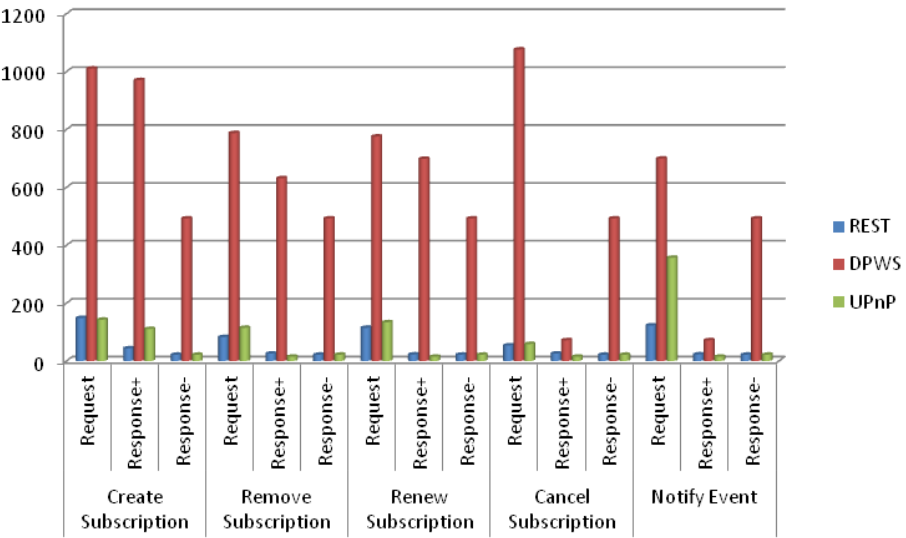
Figure 11. Comparison of message size (bytes) for eventing use